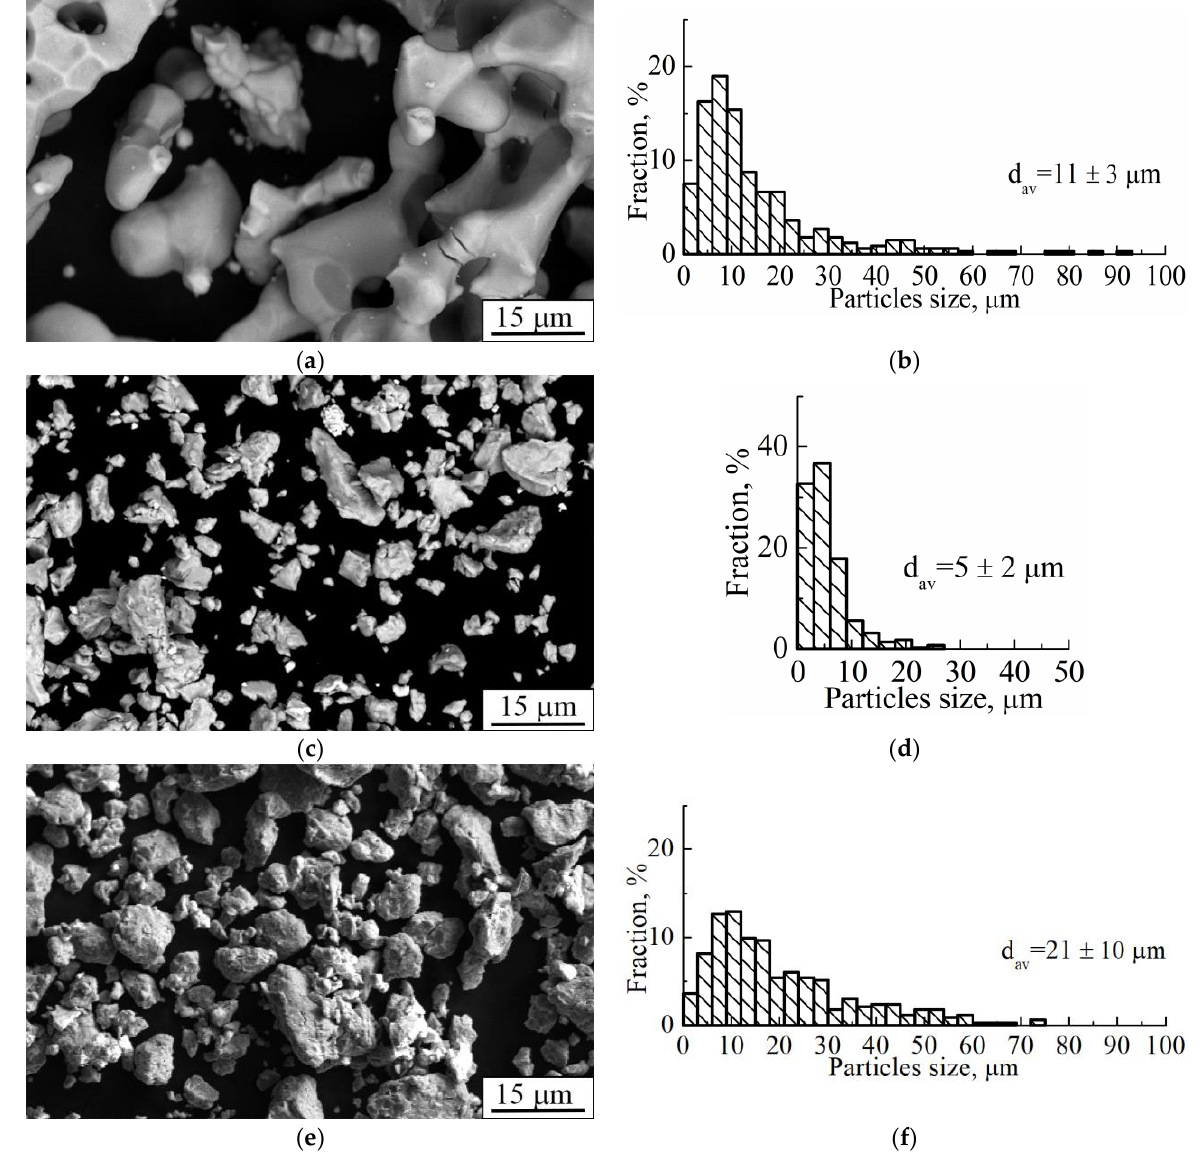
Figure 1. ( a , c , e ) SEM-image and ( b , d , f ) size distribution of powder particles of ( a , b ) titanium, ( c , d ) niobium, and ( e , f ) Ti-(40–45) wt.% Nb after mechanical alloying (d av. stands for the average particle size).